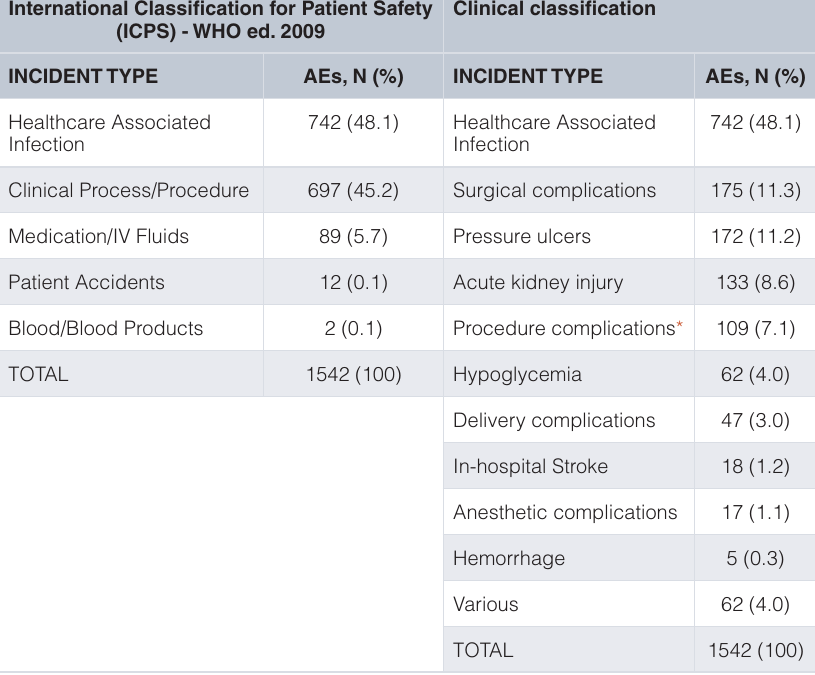
Table 5. Categorization of adverse events. International Classification for Patient Safety (ICPS) - WHO ed.